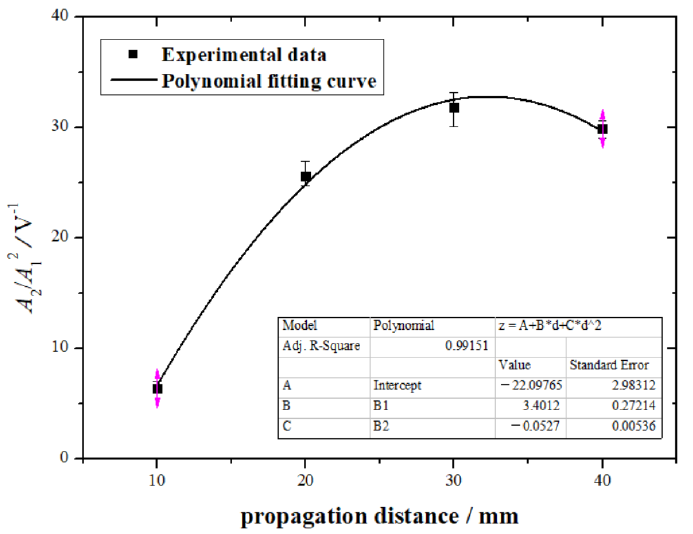
Figure 6. Relationship curve between A 2 / A 2 1 and the propagation distance of KMN vibration fatigue specimen. ( R 2 = 0.99).